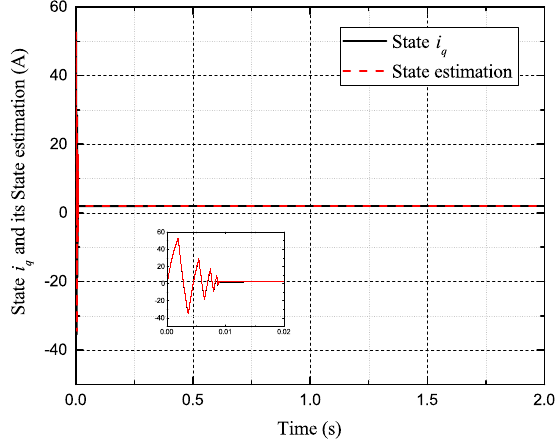
Figure 4. State i q and its estimated value ˆ i q